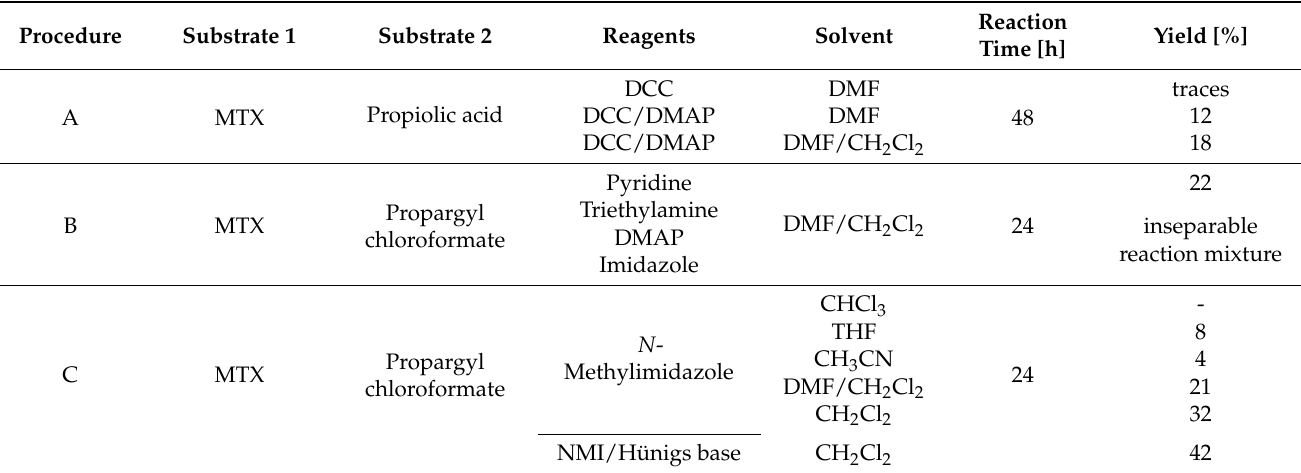
Table 1. Adjusting the condensation reaction